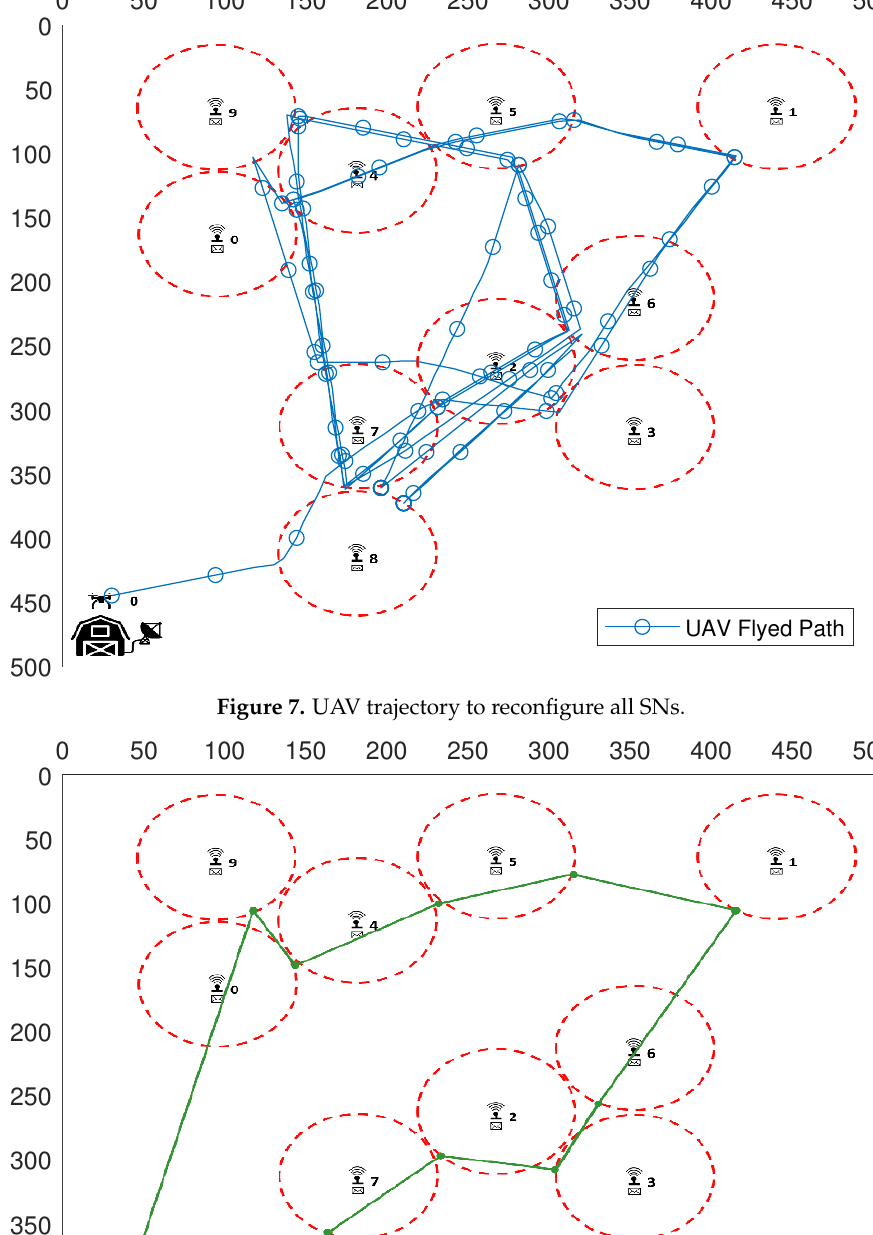
Figure 8. UAV route after SNs are